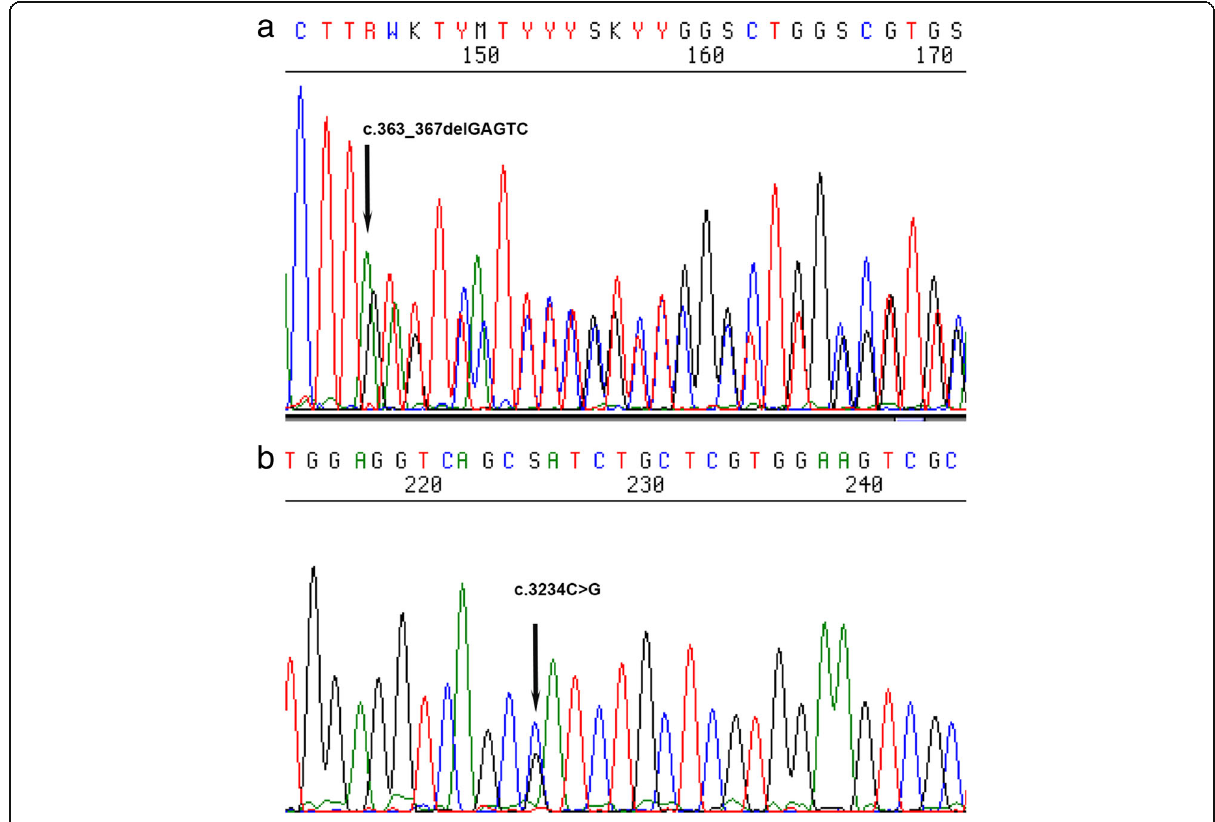
Fig. 3 Representative Sanger sequencing of PCR products showing the index patient with the biallelic variants in a . ACTA2 gene (c.363_367delGAGTC, p.Met121Ilefs*5) and b . MYH11 gene (c.3234C > G,